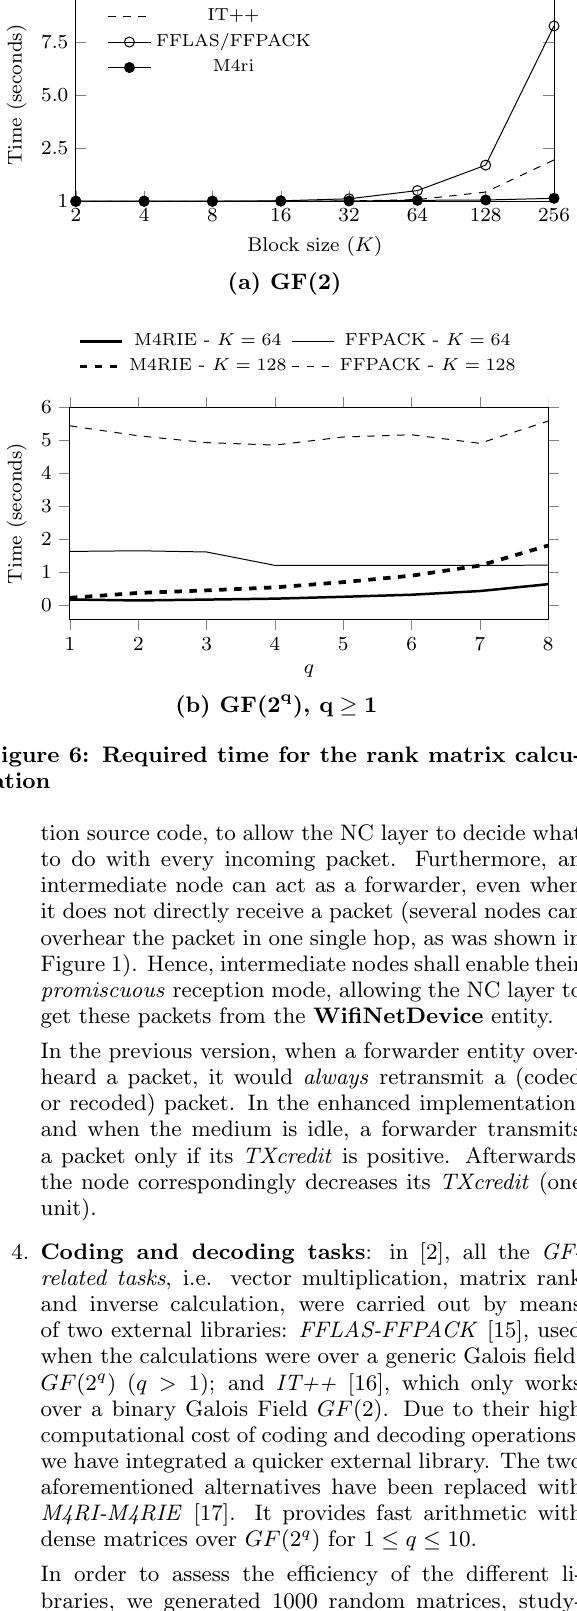
Table 1: Simulation